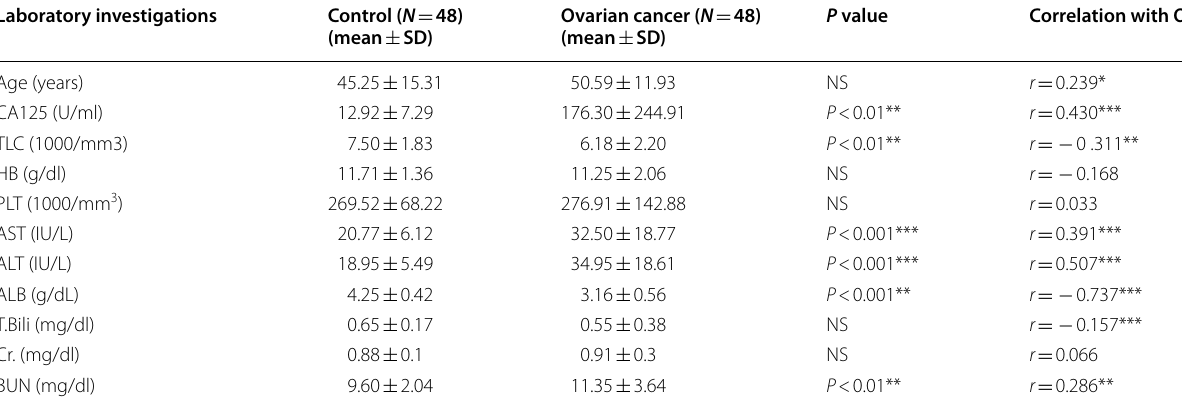
PLT Platelet, AST Aspartate aminotransferase, ALT Alanine aminotransferase, ALB Albumin, TLC Total leucocytic count, Cr Creatinine, BUN Blood urea nitrogen, CA125 Cancer antigen 125, NS not significant, HB Hemoglobin, T.Bili. Total